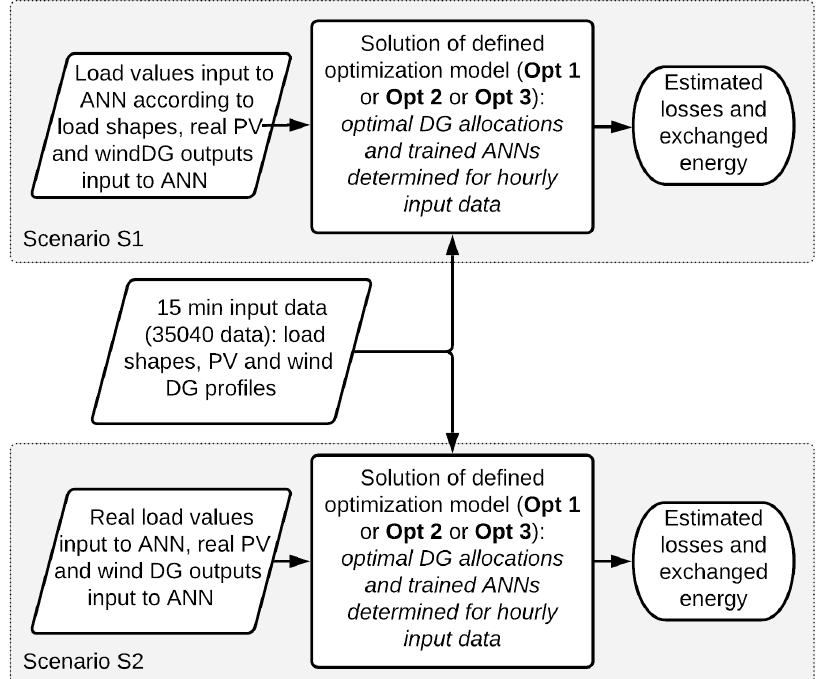
Figure 7. Scenarios for the procedure application for 15 min resolution of input